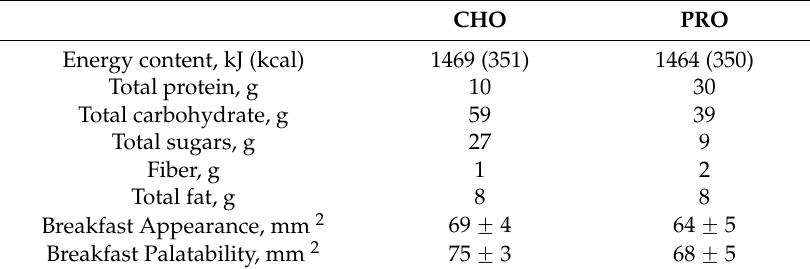
Table 1. Dietary characteristics of test breakfasts 1